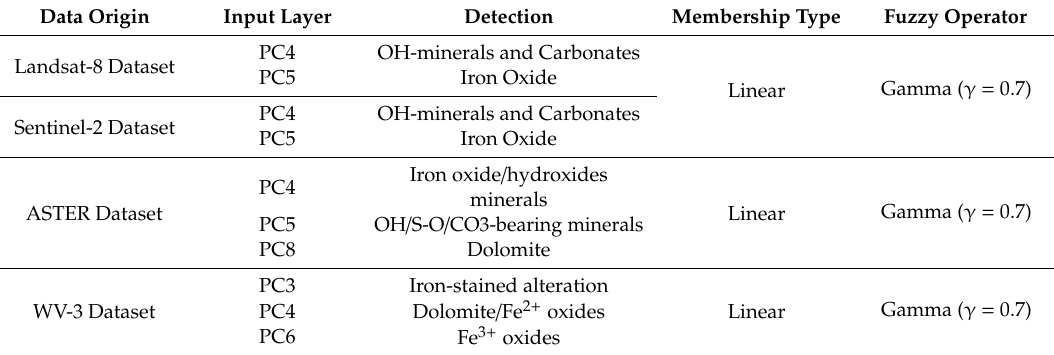
Table 6. Fuzzification parameters for the input layers used in this